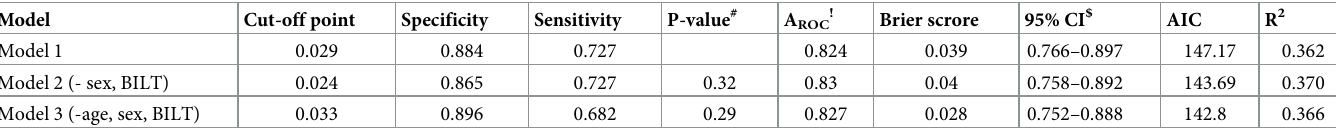
Table 7. Comparison of the performances and the evaluationsof the models.